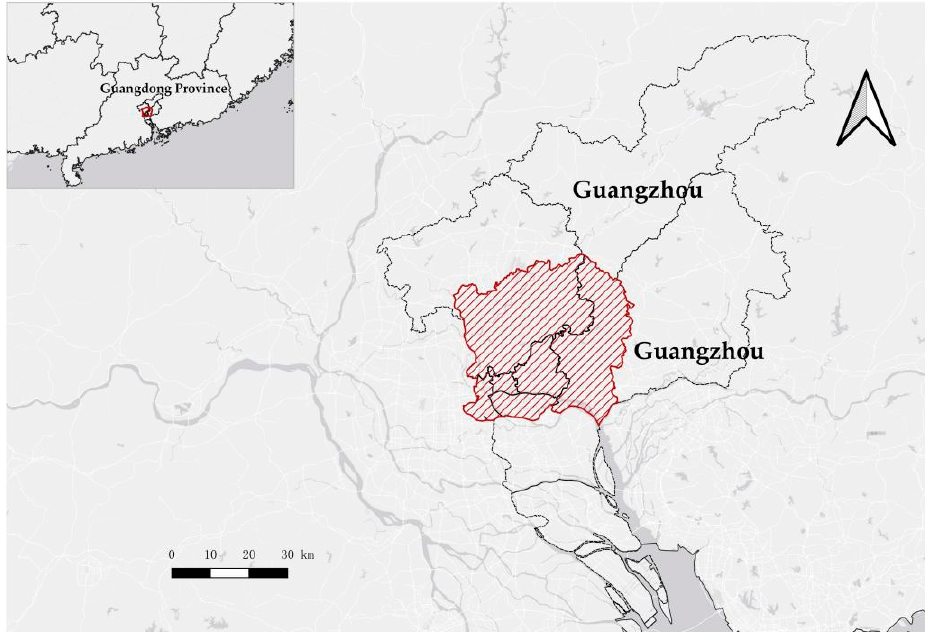
Figure 1. The geographic location of the case study area in Guangzhou Source, drawn by the authors. The background map is from ESRI.